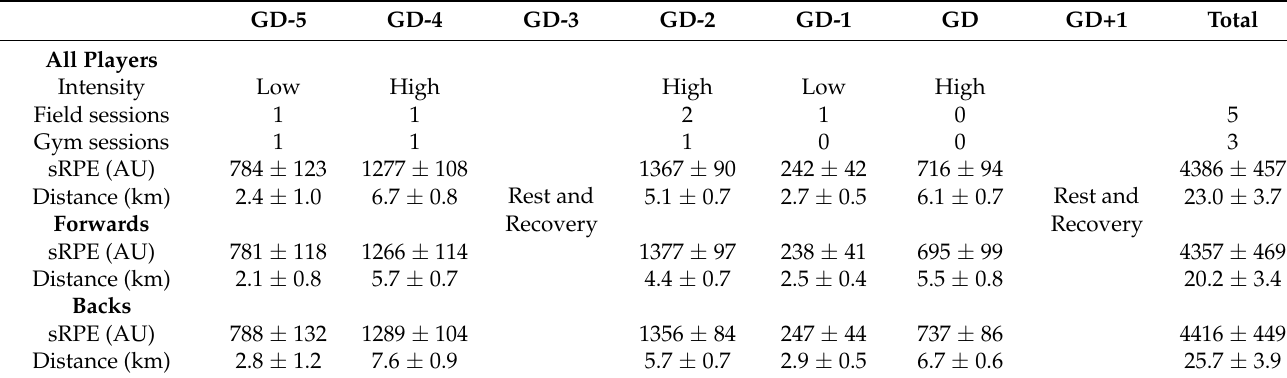
Table 1. Seven-day overview, training, and game load during the competition week. GD-5 GD-4 GD-3 GD-2 GD-1 GD GD+1